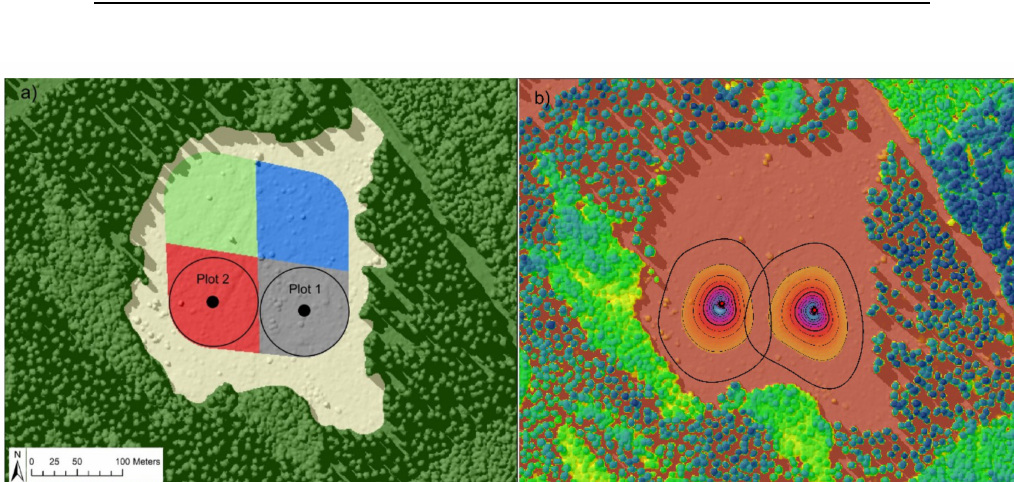
Figure 4. ( a ) Schematic picture of the land cover classifications: grey, red, blue and green fields represent footprint classes 1–4 (plots 1–4, only plots 1 and 2 are included in this study), respectively; yellow represents class 5 and dark green represents class 6. The black circles represent the maximum hourly footprint extent (50 m radius) allowed in the strictest filtering of the flux data (see Section 2.4 for details). ( b ) Footprint climatology, i.e., hourly flux footprints cumulated for the whole year 2012. Each of the black contour lines represents 10% contribution to the aggregated flux footprint, up to a maximum of 90%. The red circles represent the tower locations. The outermost contour line represents 90% contribution to the aggregated footprints. Due to significant overlap of these footprints, only contributions up to 80% were considered. The background map depicts the tree cover derived from a LiDAR survey in